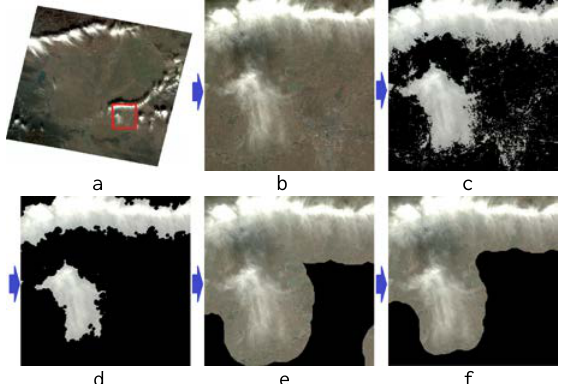
Figure 3. Morphology-based integration of cloudy areas